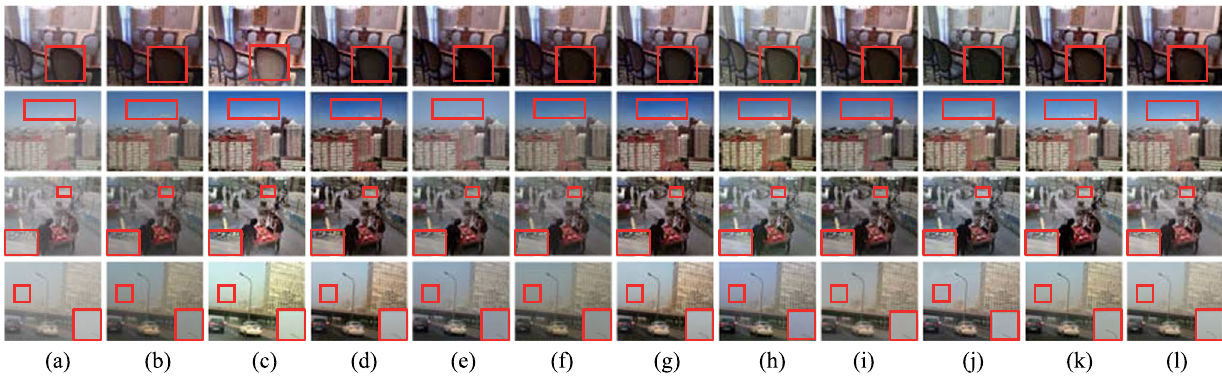
Fig. 6 SZDNet and well-known methods were compared qualitatively on the SOTS dataset. a Hazy images. b DCP [18]. c IDE [33]. d DDAP